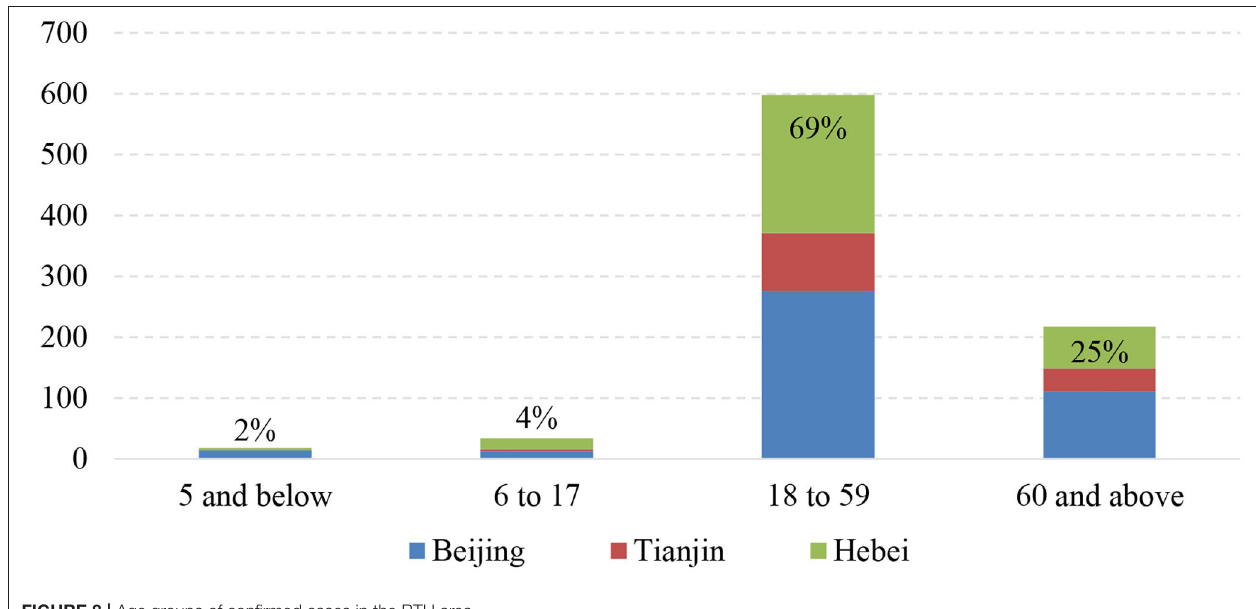
FIGURE 8 | Age groups of confirmed cases in the BTH area.